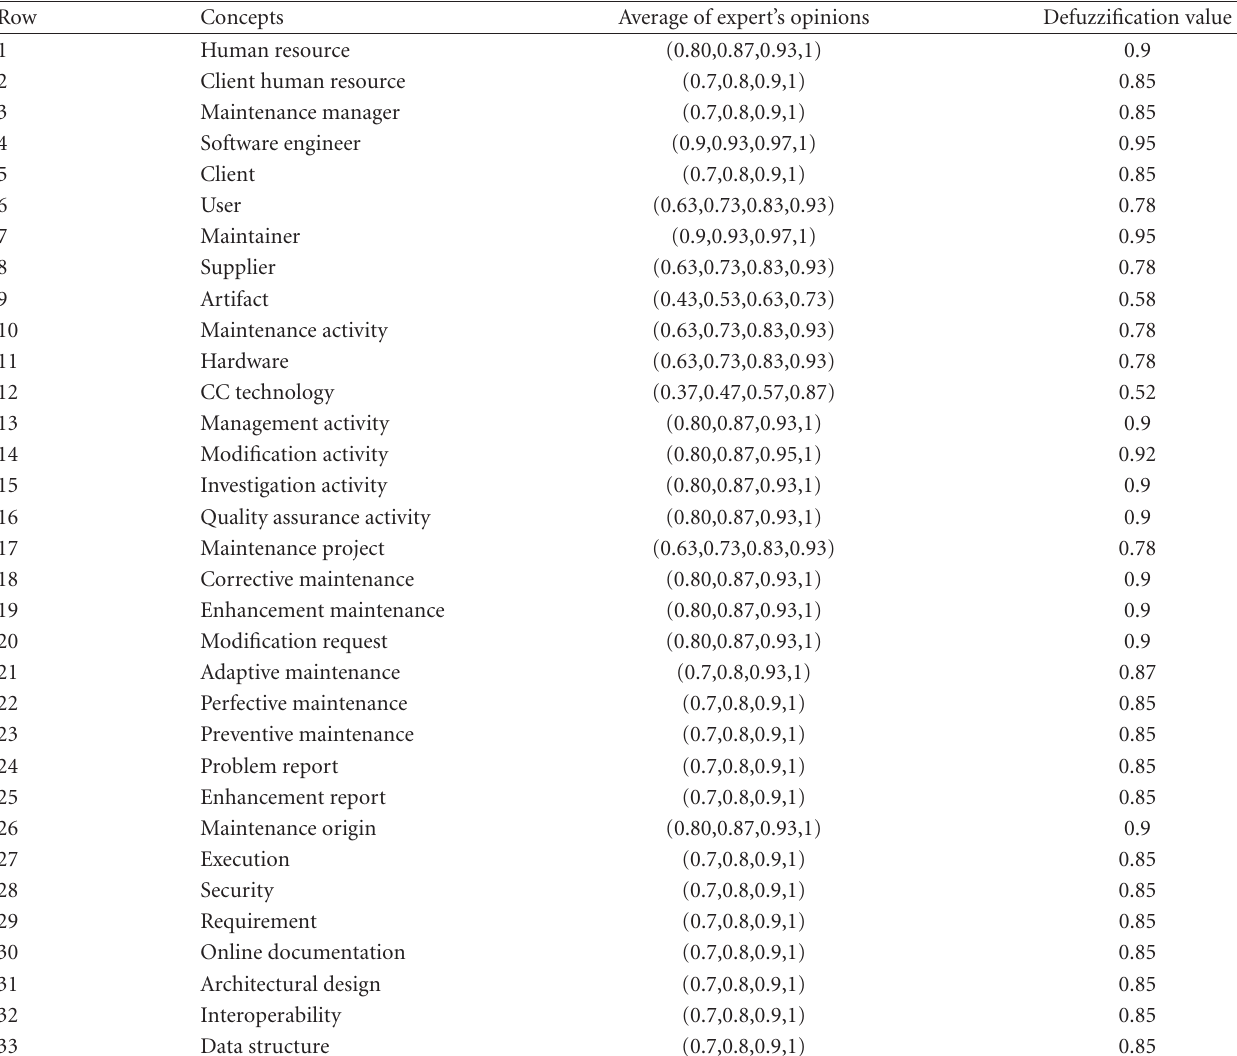
Table 1: Concept’s fuzzification results of the modification process